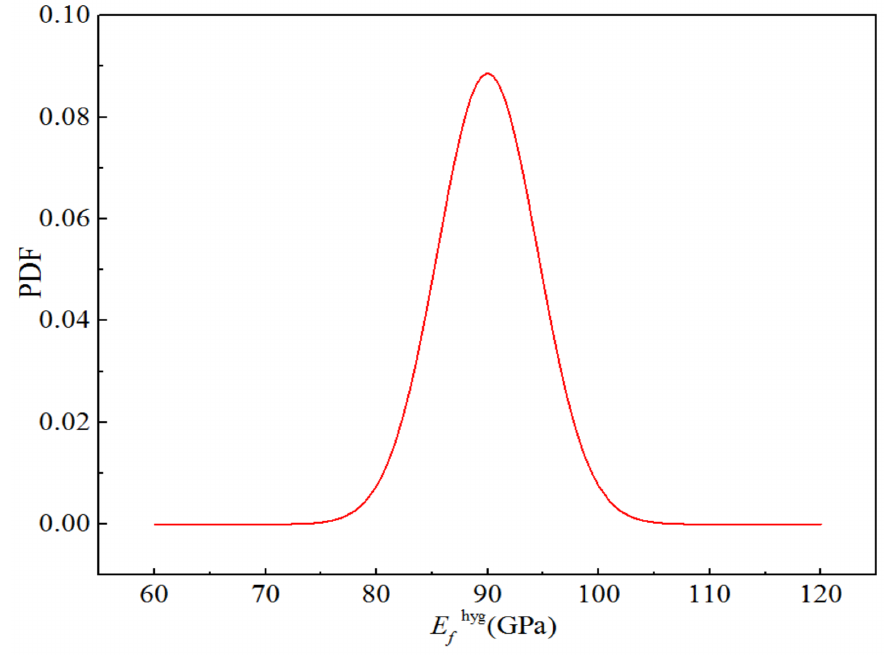
Figure 20. Probability distribution for the elastic modulus of H-GFRPs under the ETW condition.